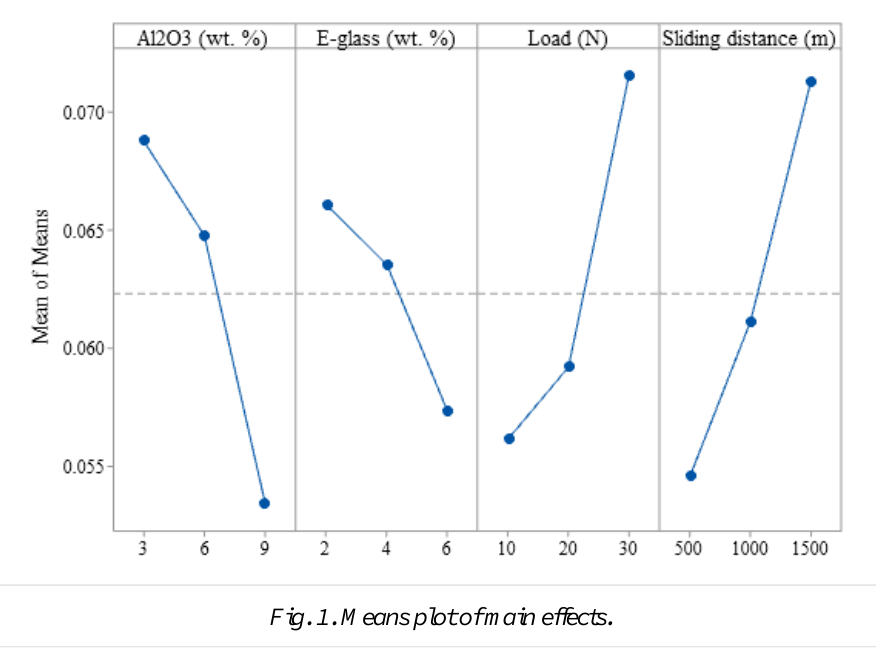
Fig. 1. Means plot of main effects.